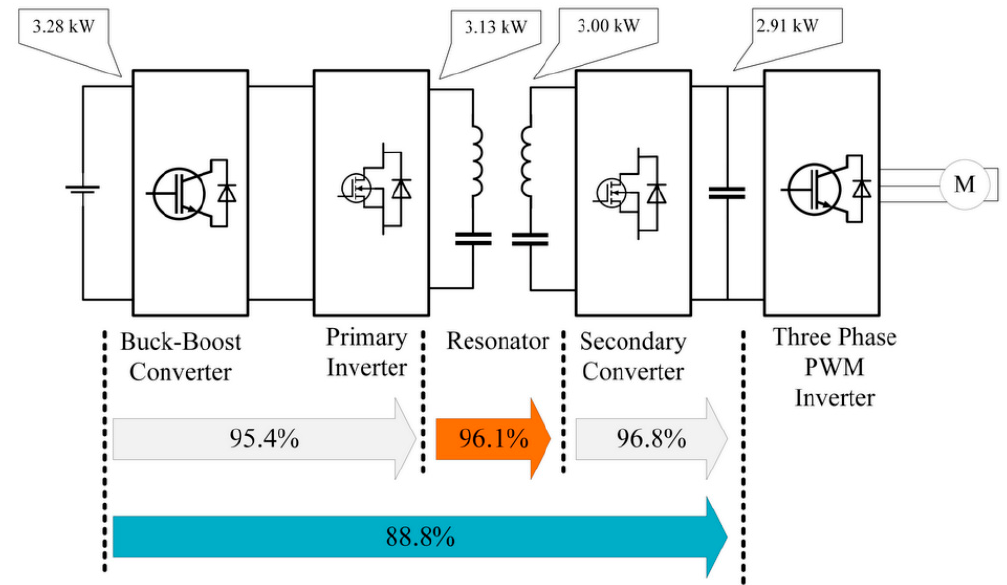
Figure 17. W-IWM setup showing efficiency at 100% torque reference. Adapted from [26].